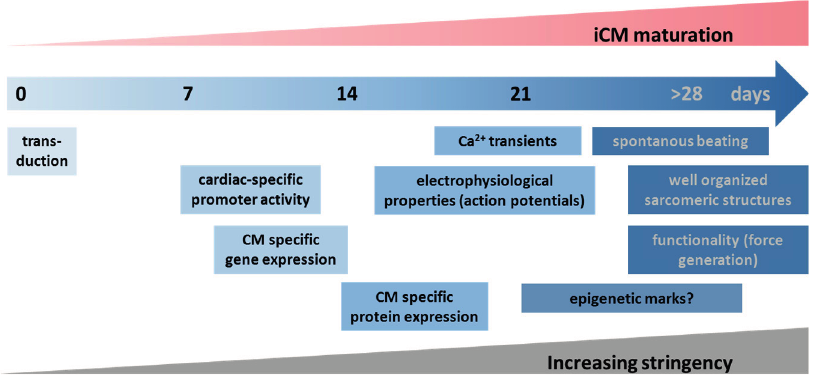
Figure 2. Reliability and temporal appearance of cardiomyocyte specific markers during the direct reprogramming process. Different markers for induced cardiomyocytes (iCMs) are depicted with increasing stringency to determine the cardioinducing effect and cellular reprogramming capacity of certain factor